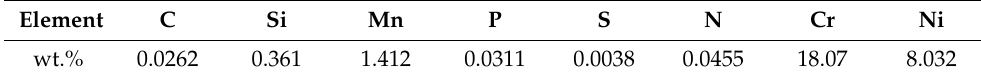
Table 1. Chemical composition of AISI 304 acc. to the manufacturer. Element C